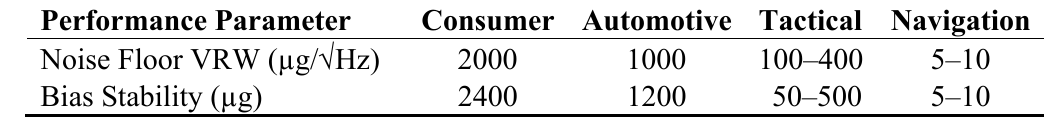
Table 2. Accelerometer